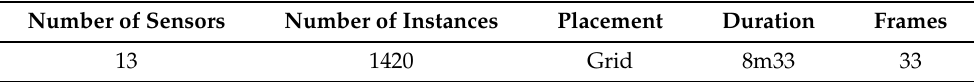
Table 1. Description of DS1 .